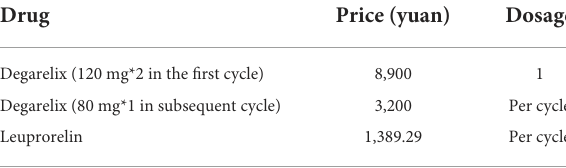
TABLE 4 The price and dosage of each